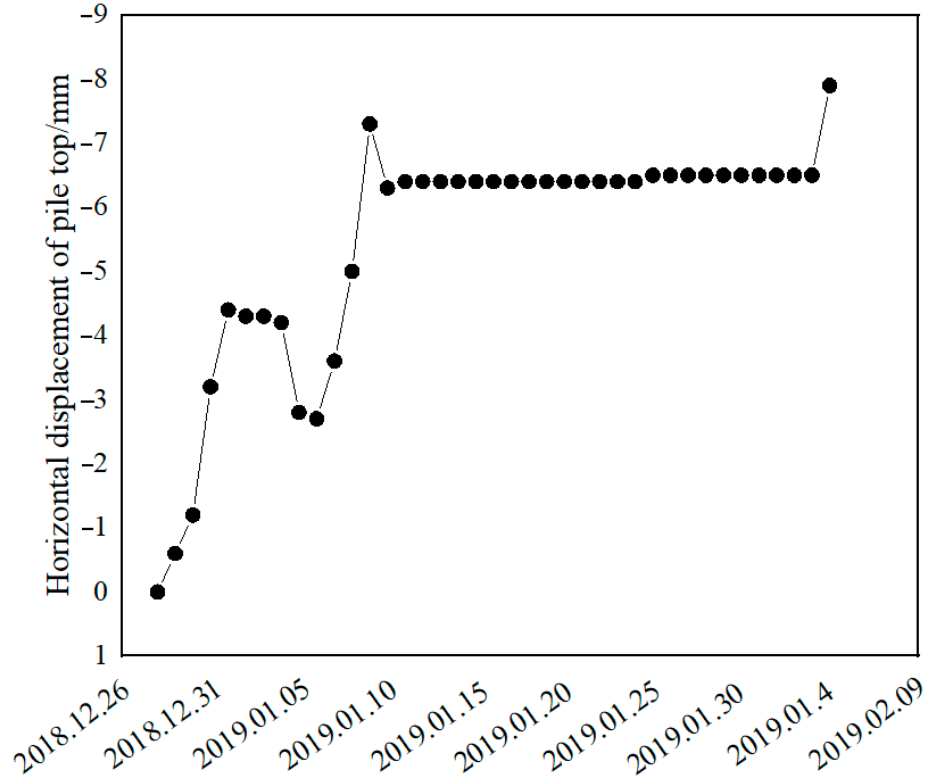
Figure 14. Monitoring of the horizontal displacement of the pile top.